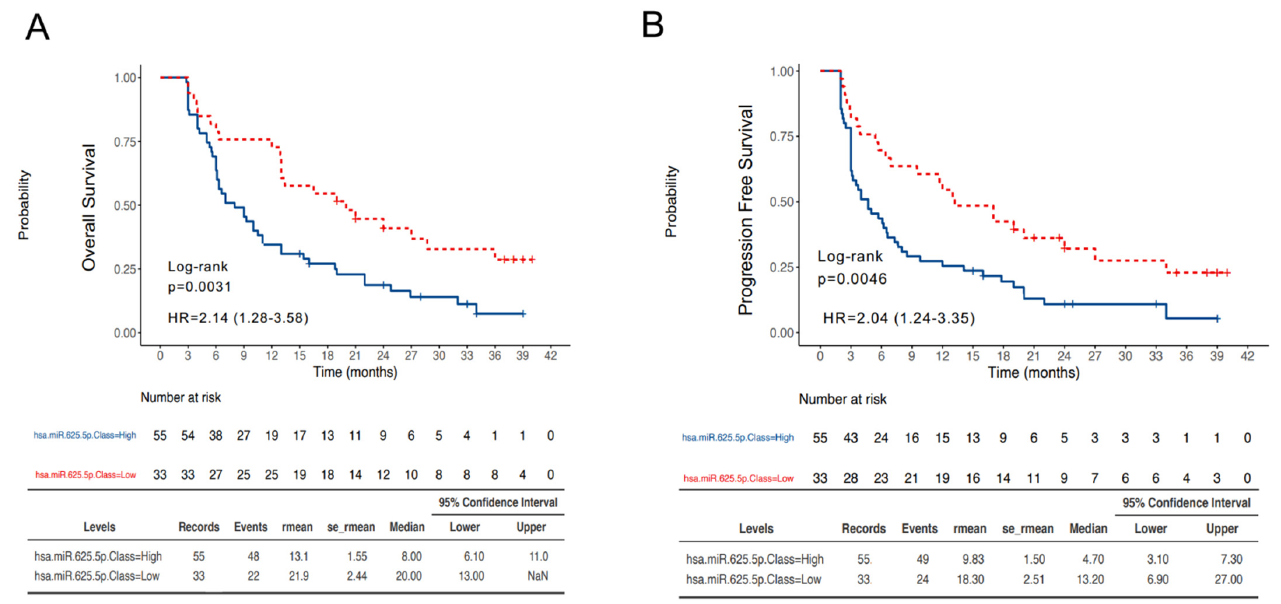
Figure 3. Survival outcomes according to miR-625-5p expression. Kaplan–Meier curves reporting the OS ( A ) and PFS ( B ) of patients dichotomized in miR-625-5p High and Low class.